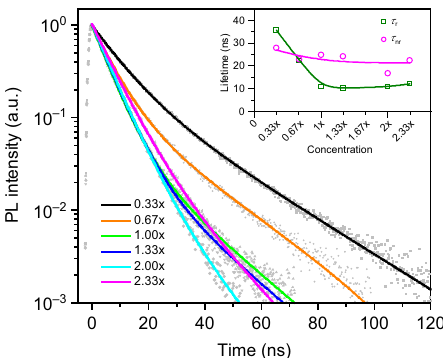
Fig. 3 Time-resolved photoluminescence decays of the samples. Time- resolved photoluminescence (PL) decays ( symbols ) and their biexponential fi ts ( solid lines ) for CH 3 NH 3 PbBr 3 NCs synthesized at room temperature are shown for different relative concentrations of the precursors, as indicated. Inset illustrates the trends of radiative ( τ r ) and nonradiative ( τ nr ) recombination lifetimes as a function of the relative precursor concentration; connecting lines are just a guide for the